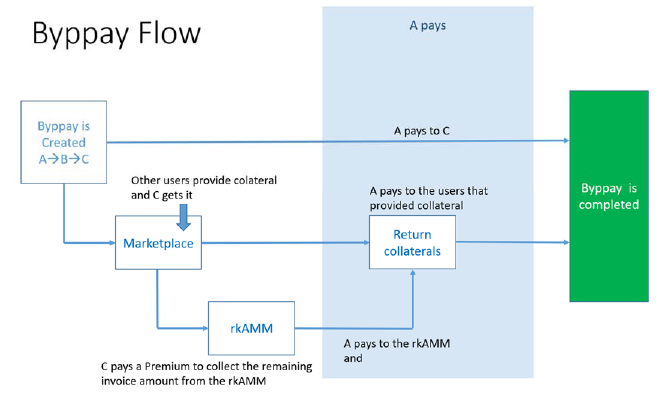
Figure 3. How the rkAMM is included in the Byppay